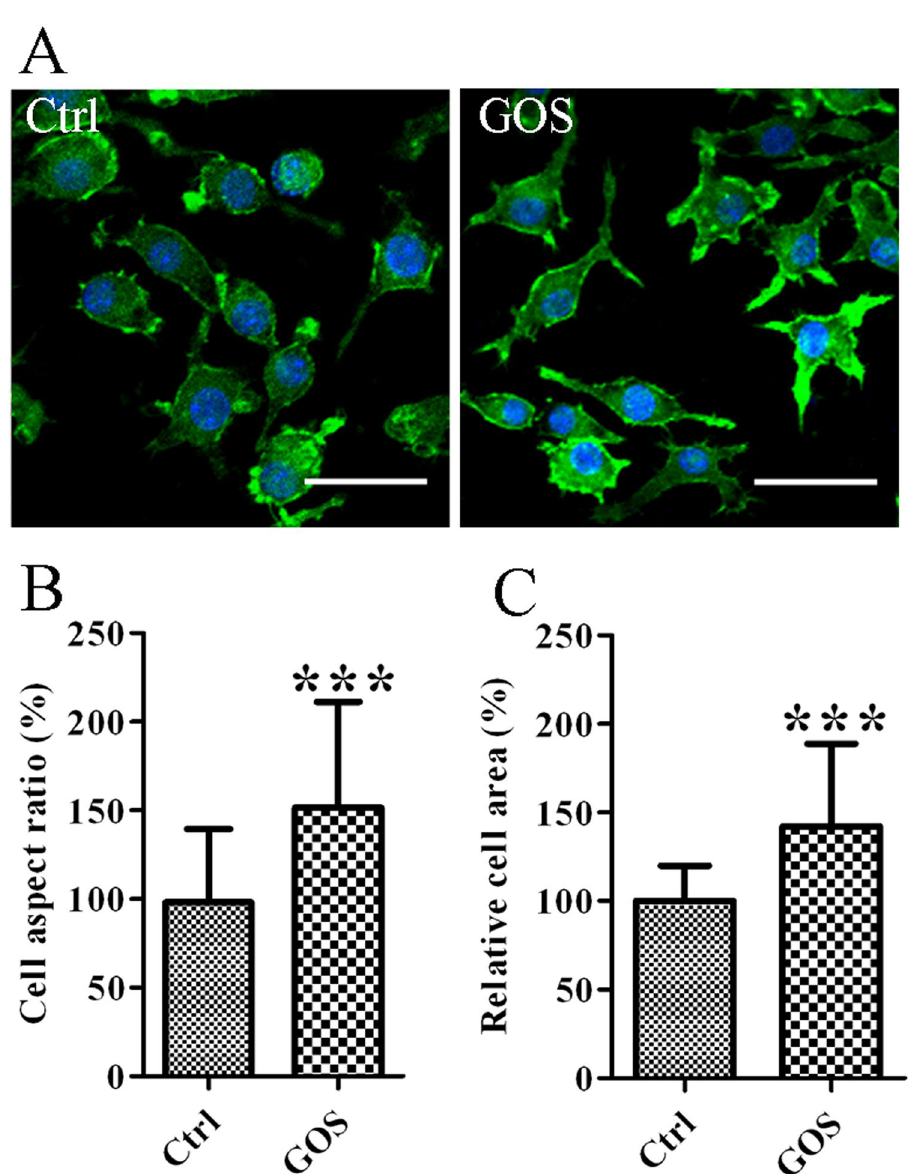
Figure 6. GOS induces changes in the morphology and cytoskeleton of RAW264.7 cells. ( A ) RAW264.7 cells were treated with 1 mg/ml GOS or medium alone (Ctrl) for 24 h and stained with FITC-phalloidin to visualize F-actin. Cell morphology was observed by laser scanning confocal microscopy (40x). Scale bar = 20 μ m. GOS- induced morphological changes including the cell aspect ratio ( B ) and cell area ( C ) were quantitatively analyzed using ImageJ software. *** P <